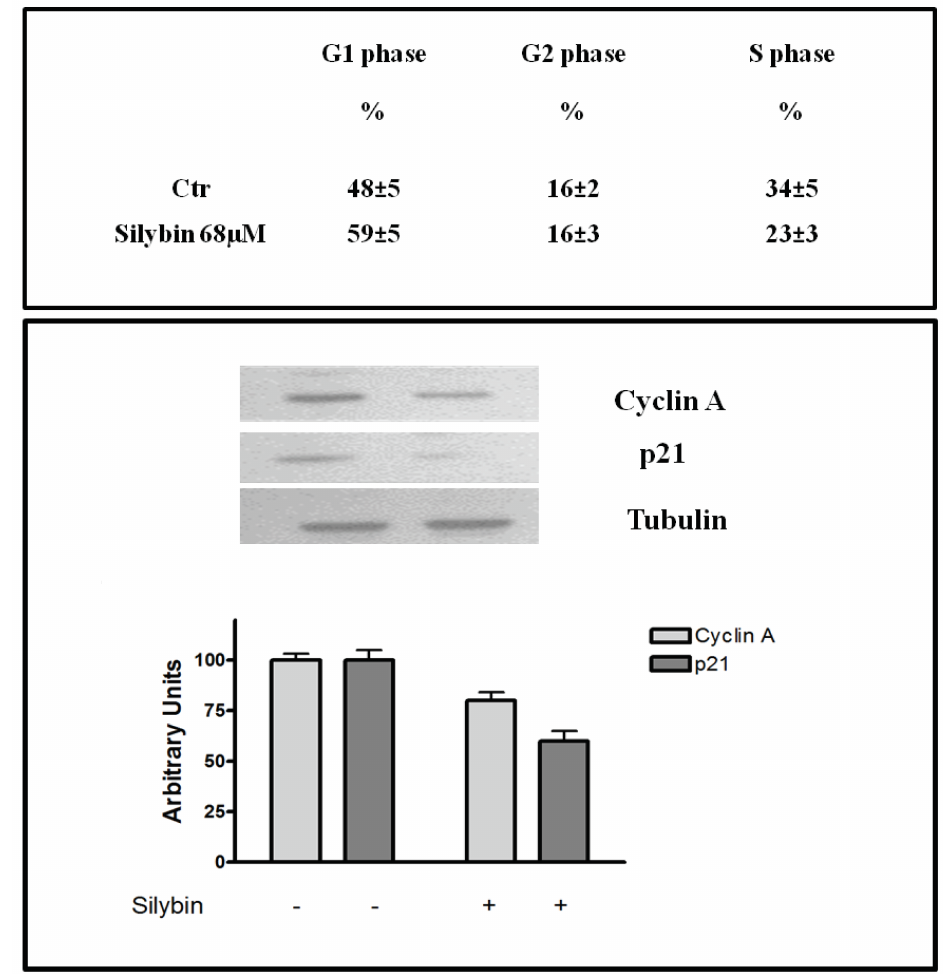
Figure 3. E ff ects of silybin on cell cycle. ( up ) Cell cycle distribution after 72 h of treatment with silybin IC50 (68 µ M) in HepG2 cells, evaluated by FACS, as described in Materials and Methods. Data are expressed as mean ± SD of the percentage of cells in the di ff erent phases of the cell cycle, as compared with untreated control cells. ( down ) E ff ects of silybin on p21 and cyclin A expression in HepG2 cells. γ -tubulin was used as loading control. The intensity of each band was expressed as % arbitrary units compared to that of the untreated cells. Error bars showed standard deviation from the mean in at least three independent